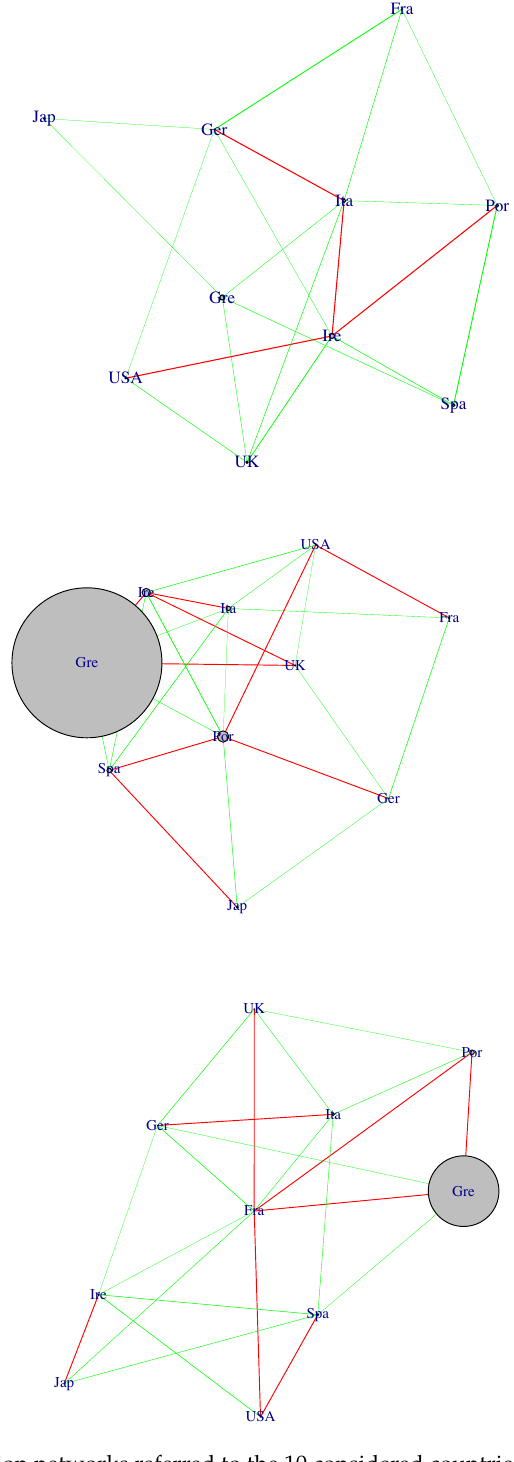
Figure 2. Partial correlation networks referred to the 10 considered countries in three different time periods (financial-crisis, sovereign-crisis, post-crisis). Green lines stand for positive partial correlations, red lines for negative correlations; the thicker the line, the stronger the connection; the larger a node, the higher the corresponding idiosyncratic probability of